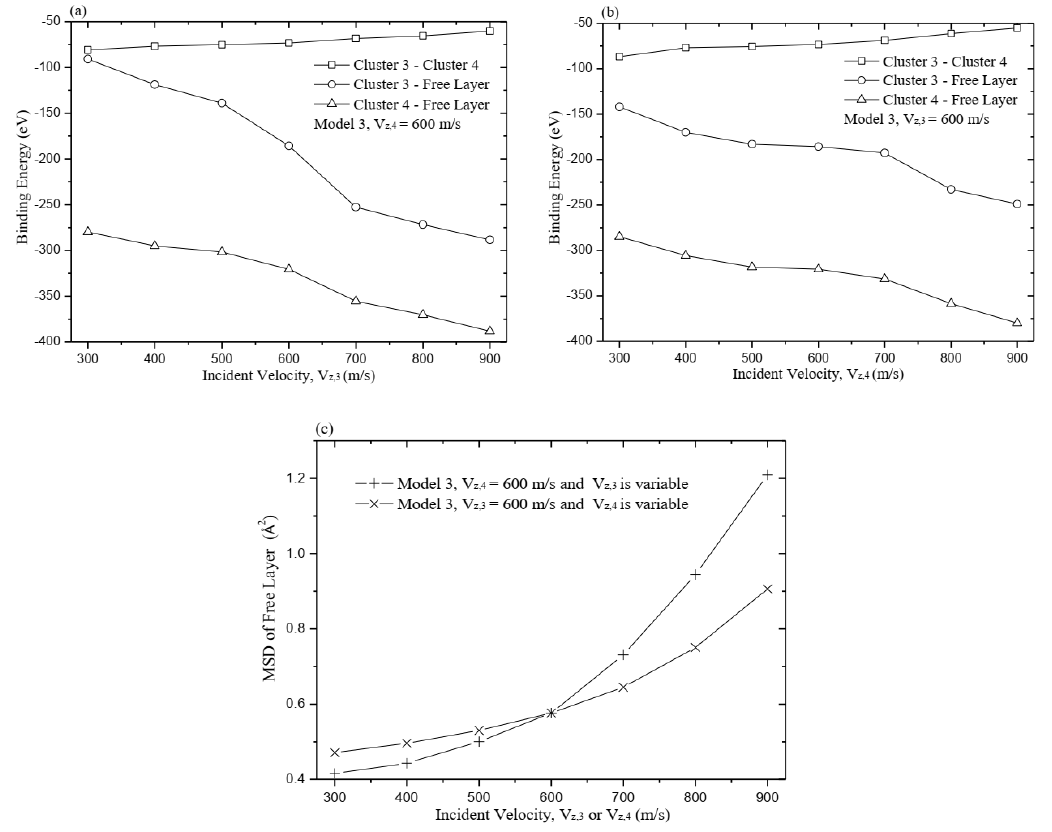
Figure 15. ( a ) Binding energy among Cluster 3, Cluster 4 and free layer at V z ,4 = 600 m/s and various V z ,3 ; ( b ) binding energy among Cluster 3, Cluster 4 and free layer at V z ,3 = 600 m/s and various V z ,4 ; and ( c ) MSD of free layer at various V z ,3 and V z ,4